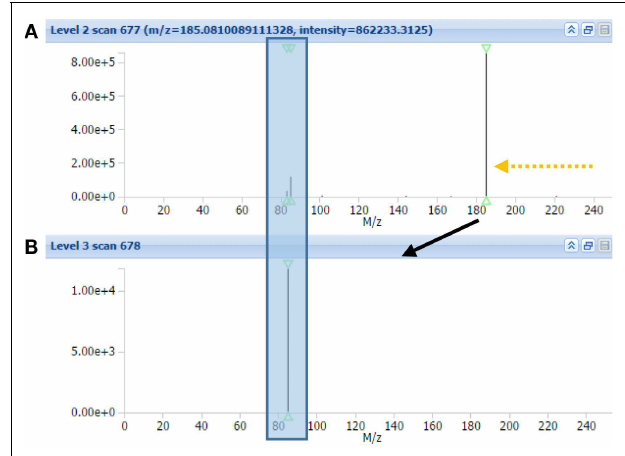
FIGURE 3 | MAGMa screenshot of CID-MS 2 spectrum (A) and CID-MS 3 spectrum (B) of HMDB-annotated tiglylcarnitine .The MS 3 scan originates from the highest abundant MS 2 ion. An arrow indicates the neutral loss of C 3 H 9 N, whereas a box captures the C 4 H 5 O 2